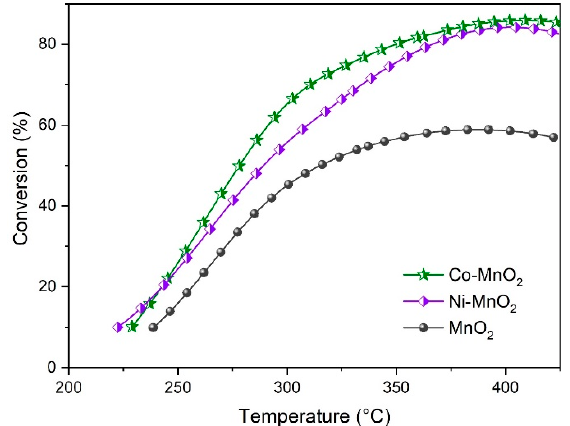
Figure 5. The catalytic activities for propane oxidation of pristine MnO 2 , Ni-MnO 2 and Co-MnO 2 samples.